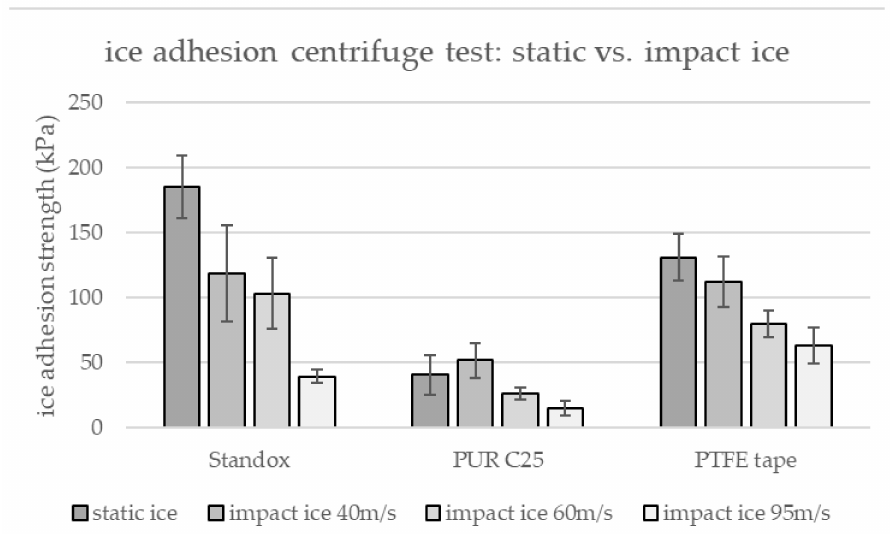
Figure 6. Comparison of the ice adhesion test results for different ice